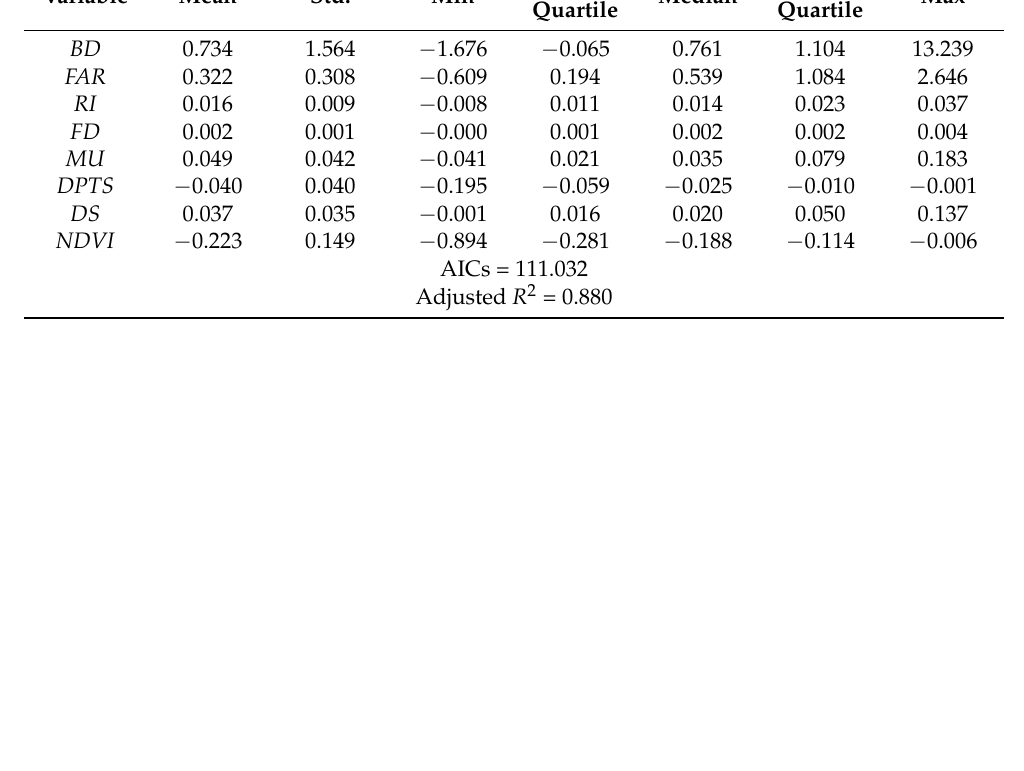
Table 5. Regression results of urban vitality by GWR model on weekdays.